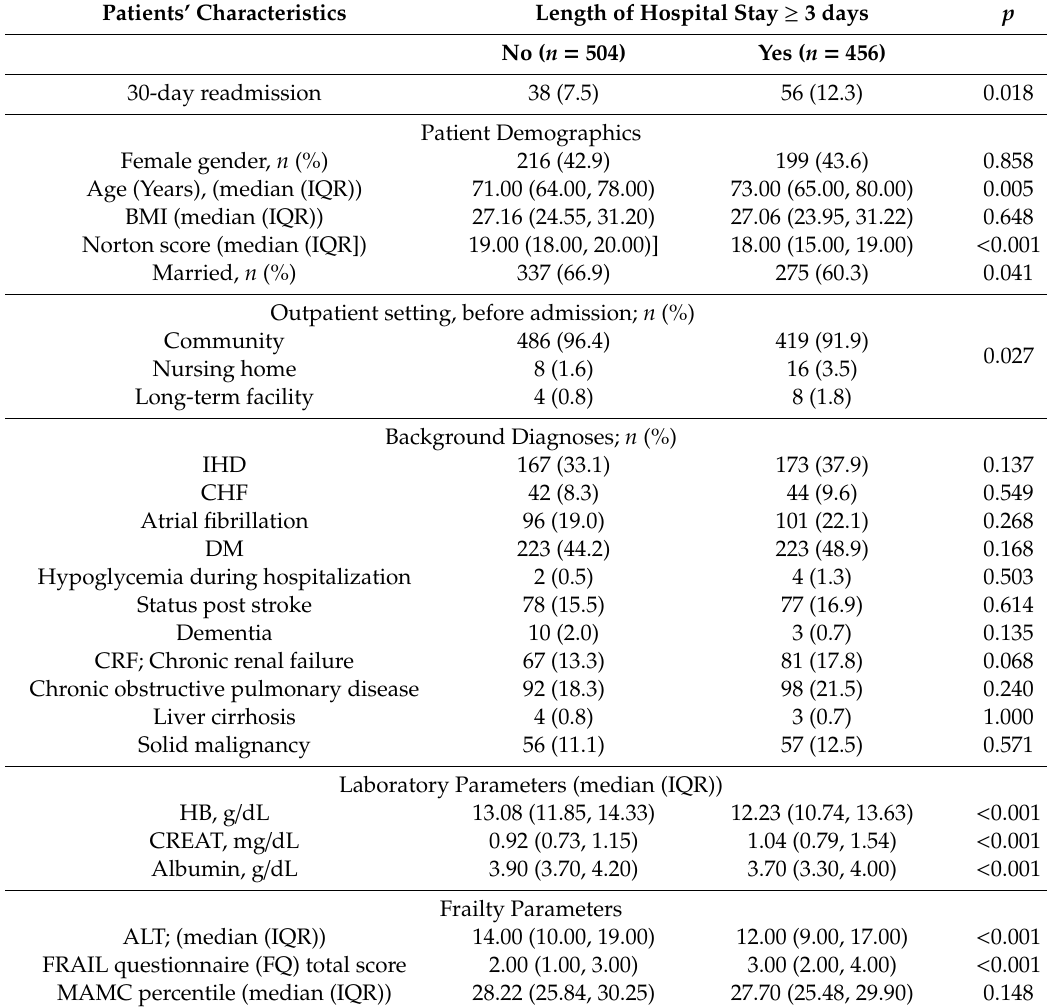
Table 2. Cohort according to LOS (patients whose LOS ≥ 14 days